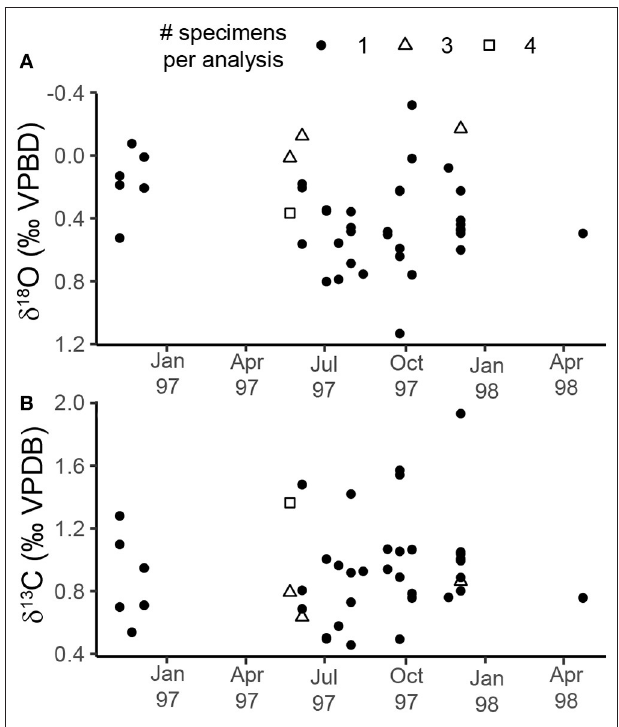
FIGURE 3 | Scatter plots showing the changes in: (A) δ 18 O, and (B) δ 13 C throughout the study period for the sediment trap. The shape of the point represents the number of specimens pooled per isotopic analysis (see key at top of figure). Following convention, the δ 18 O axis is inverted. The breaks in the record correspond to times when pteropods were not found in the faunal splits from the sediment trap samples. TABLE 3 | Definitions of the δ 18 O values used in this